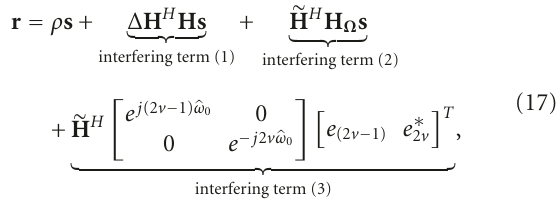
= (2 π/ 30) 2 , (2 π/ 50) 2 , ω